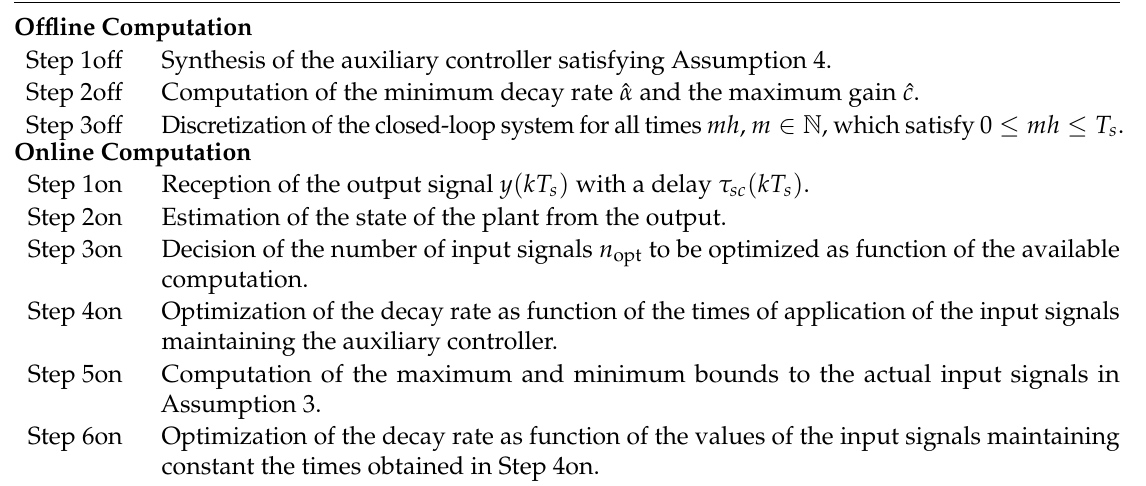
Algorithm 1 Optimization algorithm with limited computation